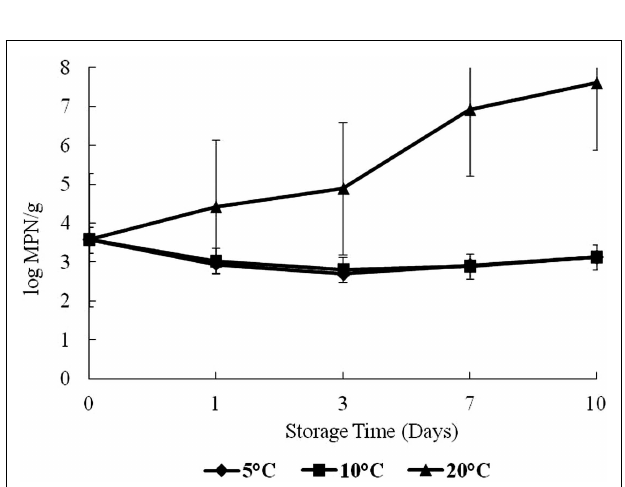
FIGURE 5 | Freshness as determined by visual appearance with time (days) and temperature (5, 10, and 20°C), shown as percent of full scale, 100 = fresh, 0 = not fresh